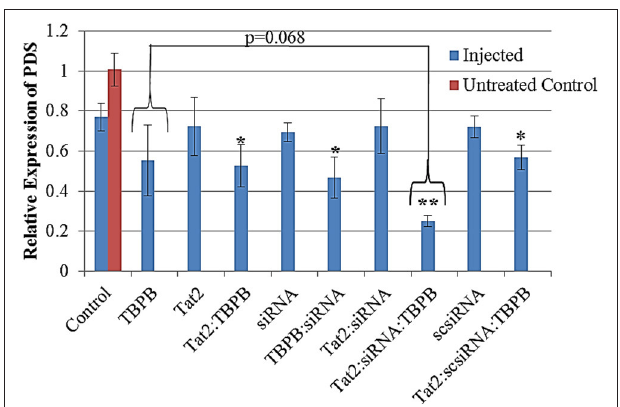
FIGURE 5 | Relative expression of PDS from seedling Triticale (Sunray) leaves converted from 11 Ct values, normalized against ADP-RF. All data was calibrated against an untreated control (Red bar, n = 3). A significance level of p = 0.00024 was found for the difference between treatments containing TBPB and those without using ANOVA. The (*) and (**) indicate a significance of p < 0.05 and p < 0.0001 between the designated treatment and the Control (solvent only), based on Student’s t -test. Data displayed are means ± s.e. n =